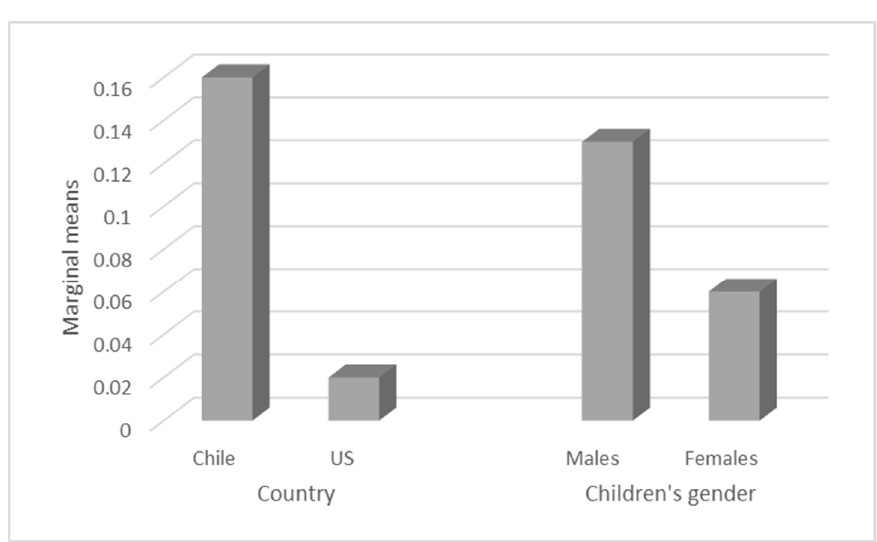
Figure 1. Distribution of the marginal means of regulatory talk at 12 months, controlled for country and children’s gender.